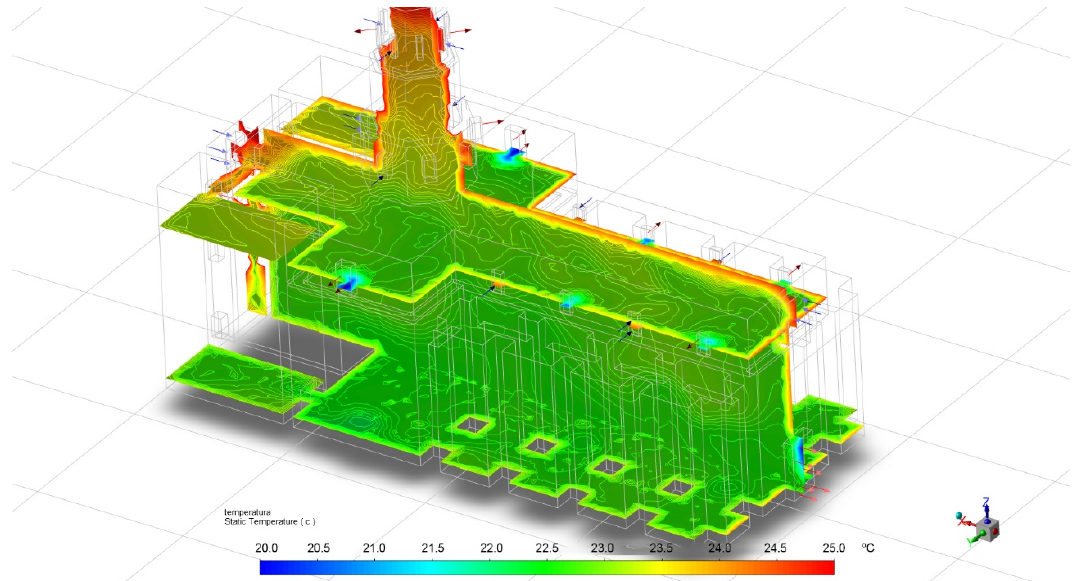
Figure 11. CFD simulation to compare results with sensors and IRT